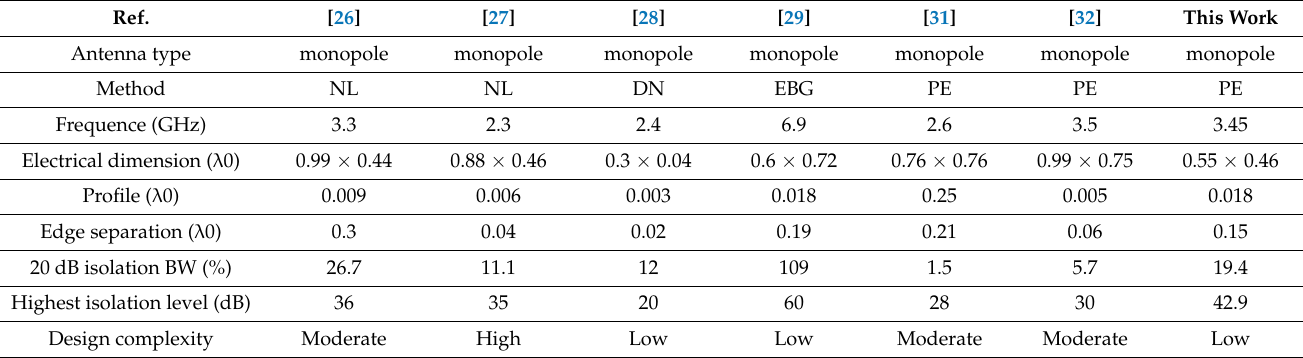
Table 2. Comparison of the proposed antenna with previous